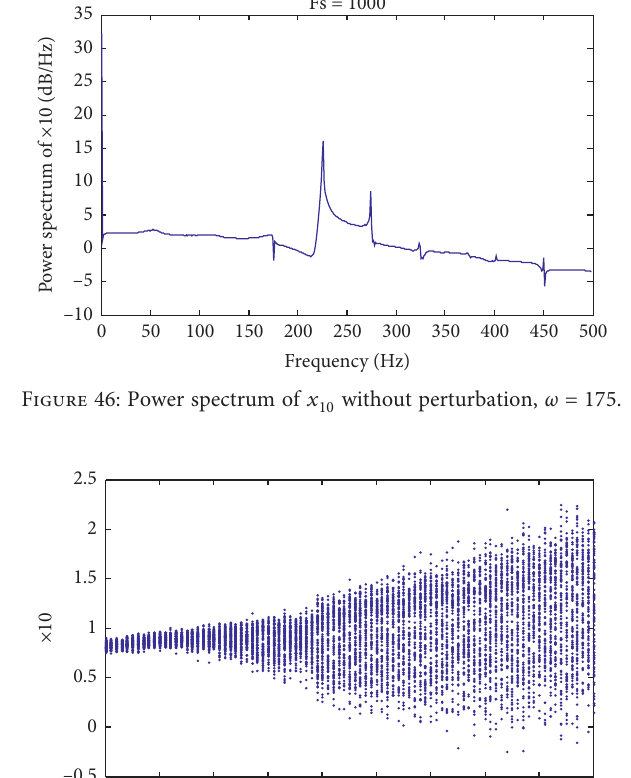
Figure 47: Vibrational bifurcation random diagram with δ ∗ F ∼ N ( 0 , 0 . 01 2 ) .